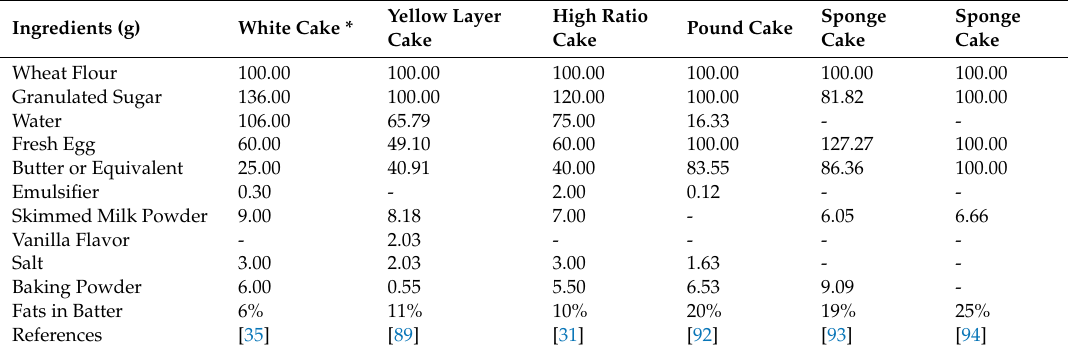
Table 4. Cake batter recipes based on 100 g wheat flour.